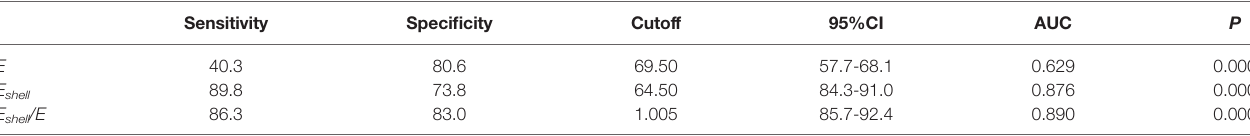
TABLE 3 | Diagnostic performance of all acquired quantitative parameters.